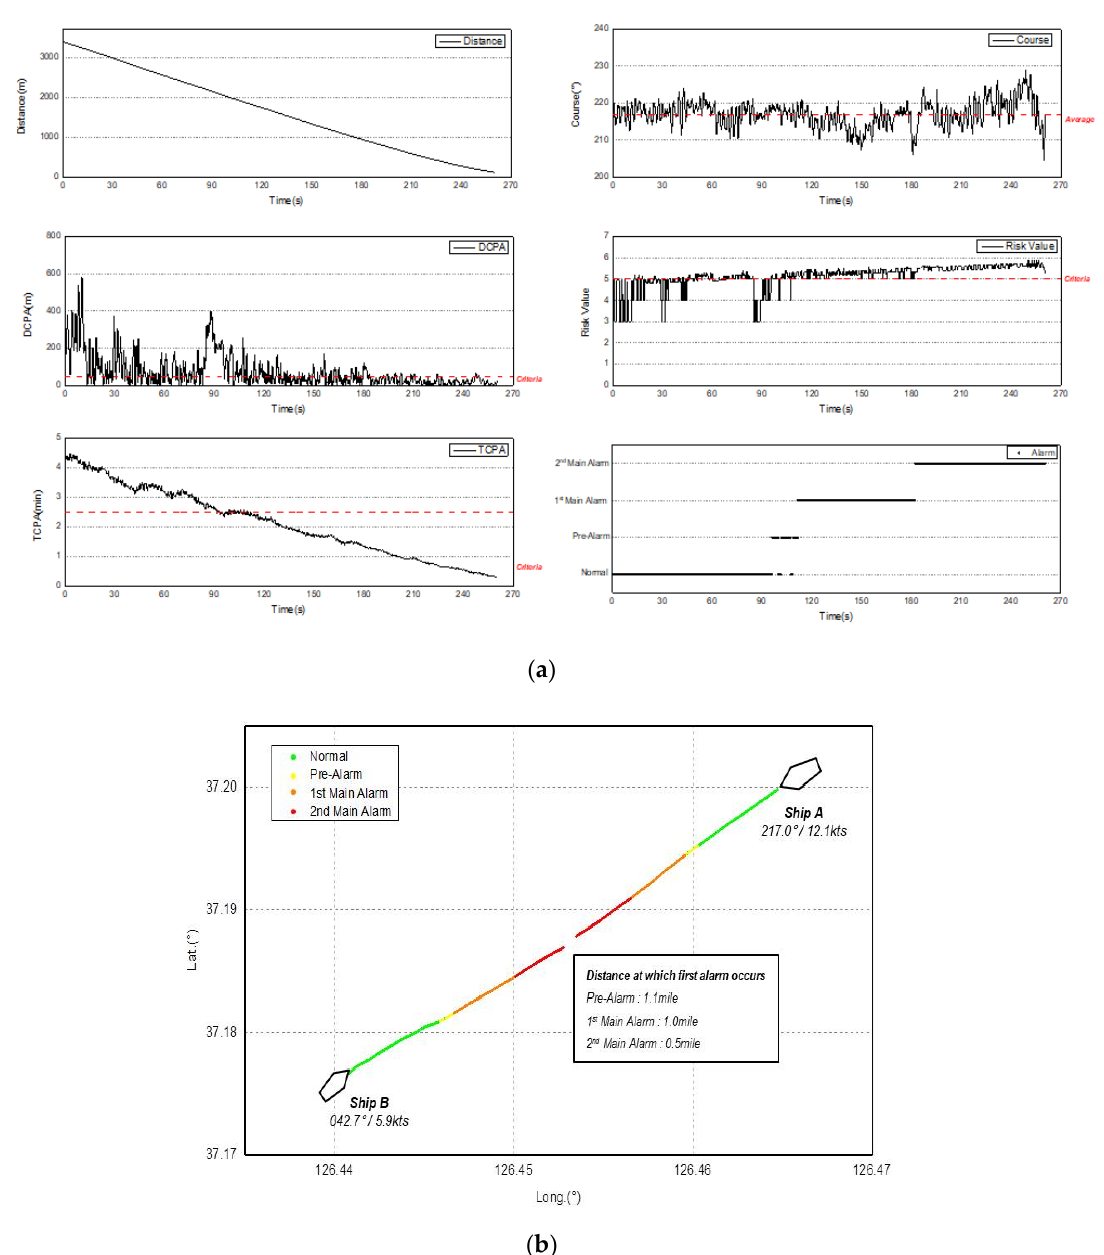
Figure 11. ( a ) Experimental results; ( b ) track and alarm analysis for S 1